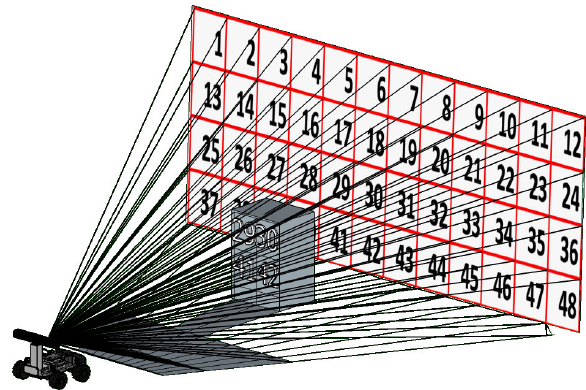
Figure 3. 3D reconstruction of the Kinect [11, 12].